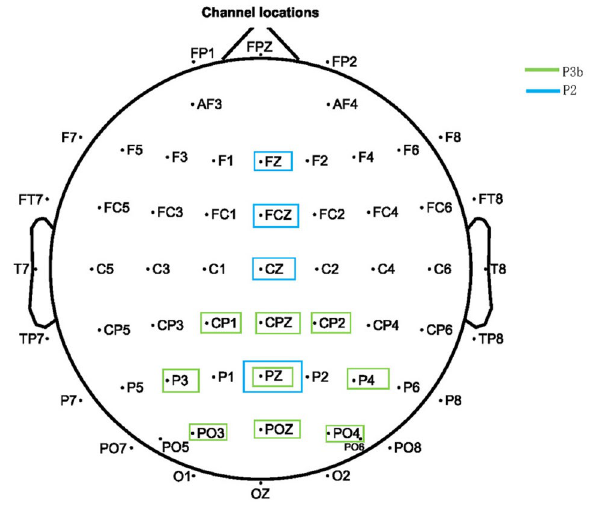
Fig. 4 P2/P3 analysis electrodes. Electrodes that are used to analyze P2 component are included in blue box. Electrodes that are used to analyze P3b component are included in the green box